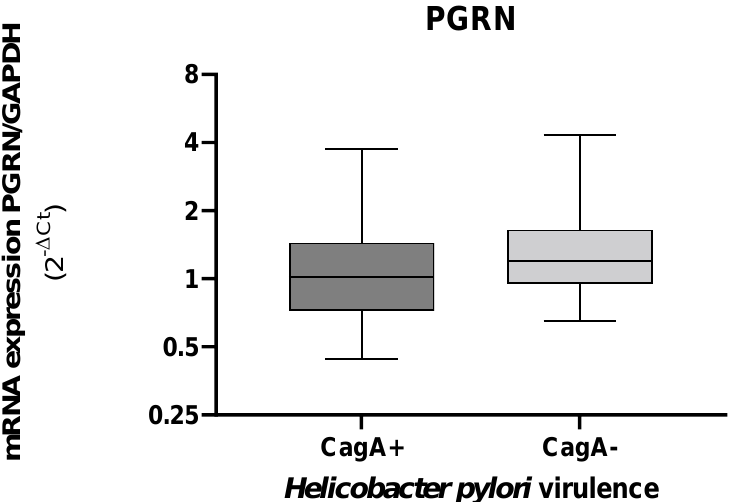
Figure 6. Expression levels of GRN mRNA in gastric tissue according to the presence or absence of the H. pylori cagA . The GRN expression values calculated by the formula 2 ΔCt, where ΔCt = Ct of GRN − Ct of GAPDH . Bacterial DNA amplification for the cagA and by the PCR (Polymerase Chain Reaction), visualized in gel of agarose 1.5% (Cleaver Scientific. Rugby, UK). Data compared by non-parametric Mann–Whitney test. Statistical significance p < 0.05.